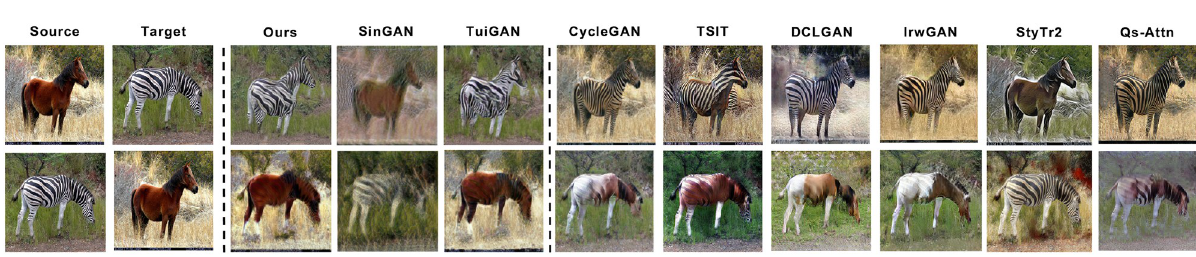
Fig 6. Translation results of CRPGAN with various baselines on Summer $ Winter. Among them, SinGAN is trained using one target domain image, TuiGAN and CRPGAN in this paper are trained using two unpaired images, others are trained using the complete dataset.